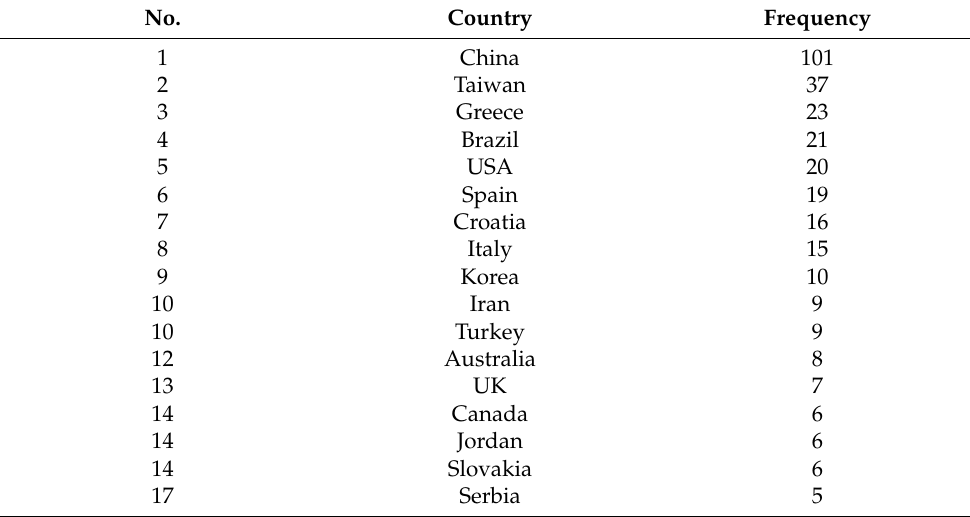
Table 20. List of the top 17 countries that authors are affiliated with.